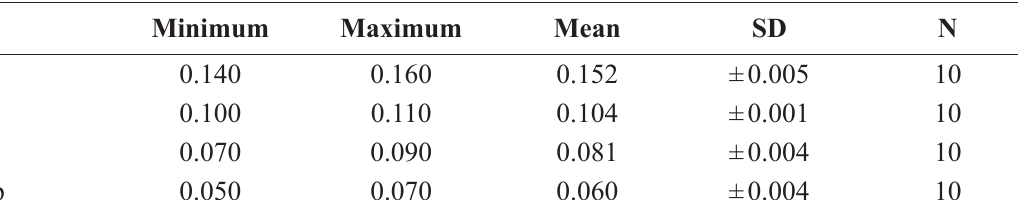
Table 5. Measurements in mm of Cupuladria sp. (GIS/B 0471 to 0503), Aquitanian, lower Miocene,